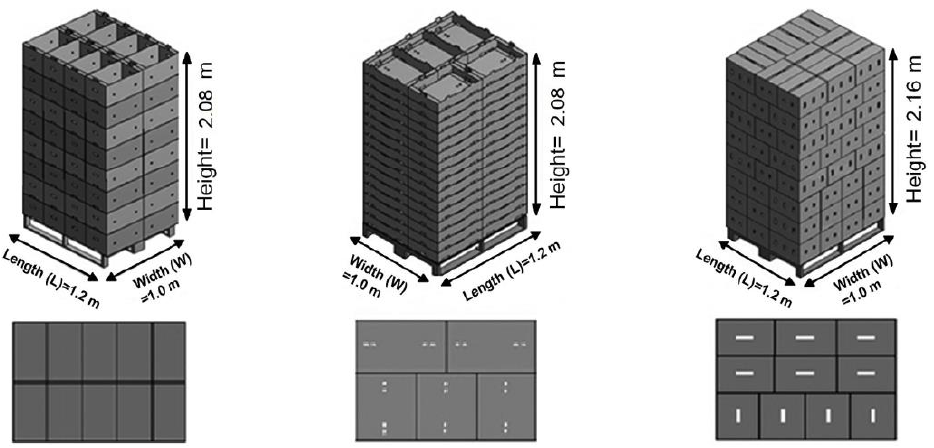
Figure 7. Different packaging box designs and different stacking patterns [90] .